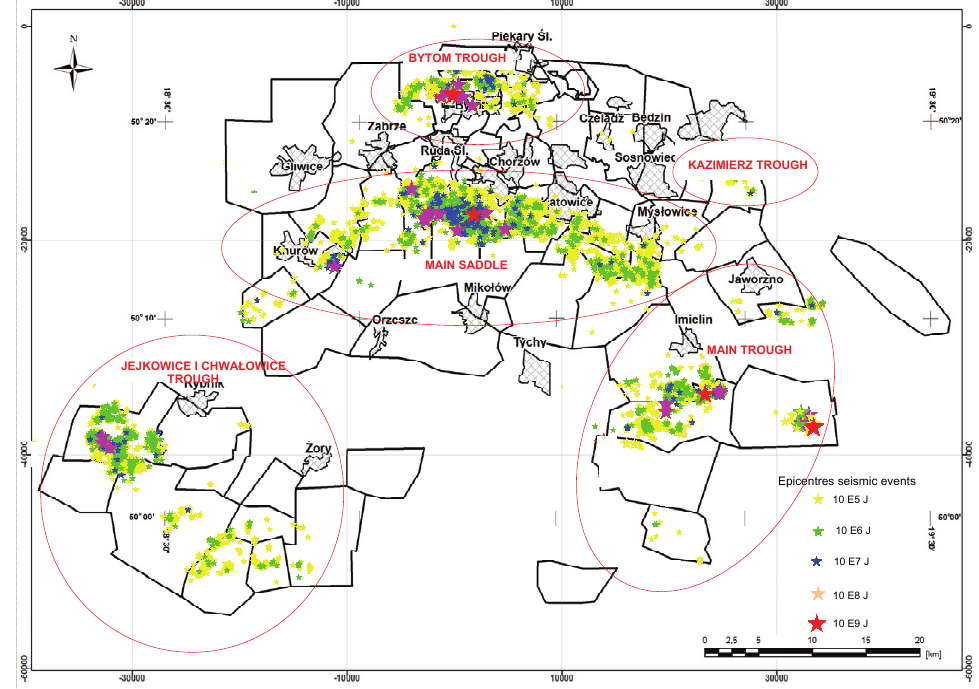
Fig. 3. Location of epicentres seismic events in USCB between 2001 and 2015 against the background of the mining